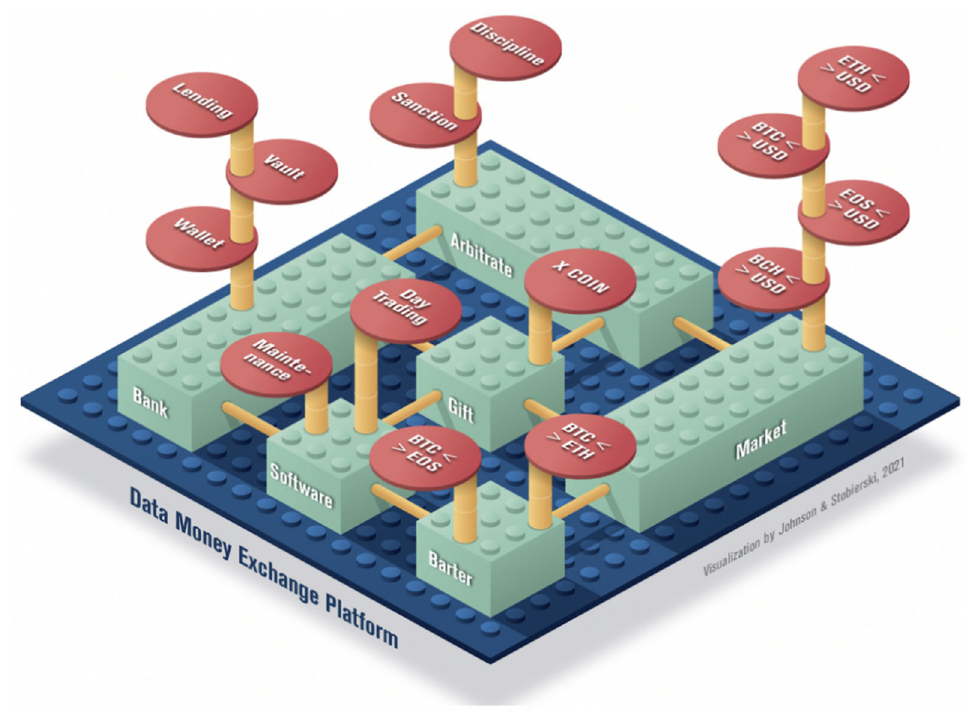
Figure 1. X Exchange Platform as a Stack and Modular Economization Process.